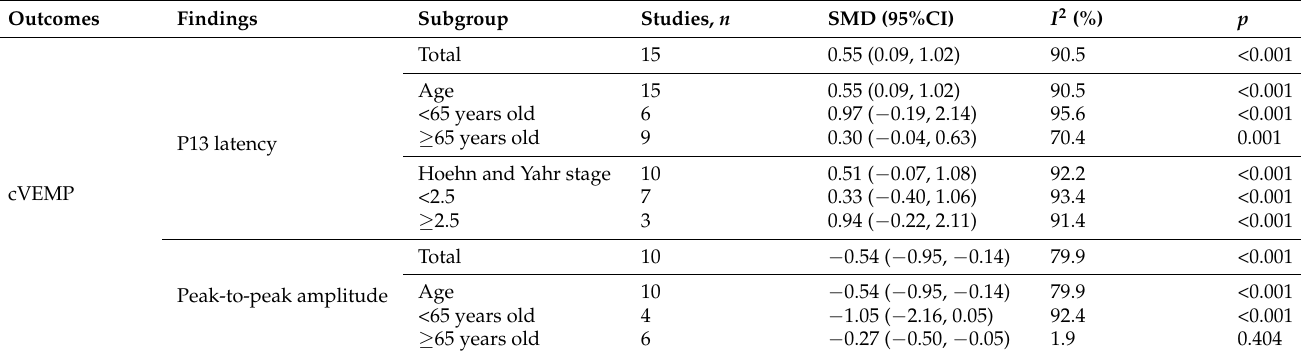
Table 2. Subgroup analyses of findings of VEMP tests between PD and